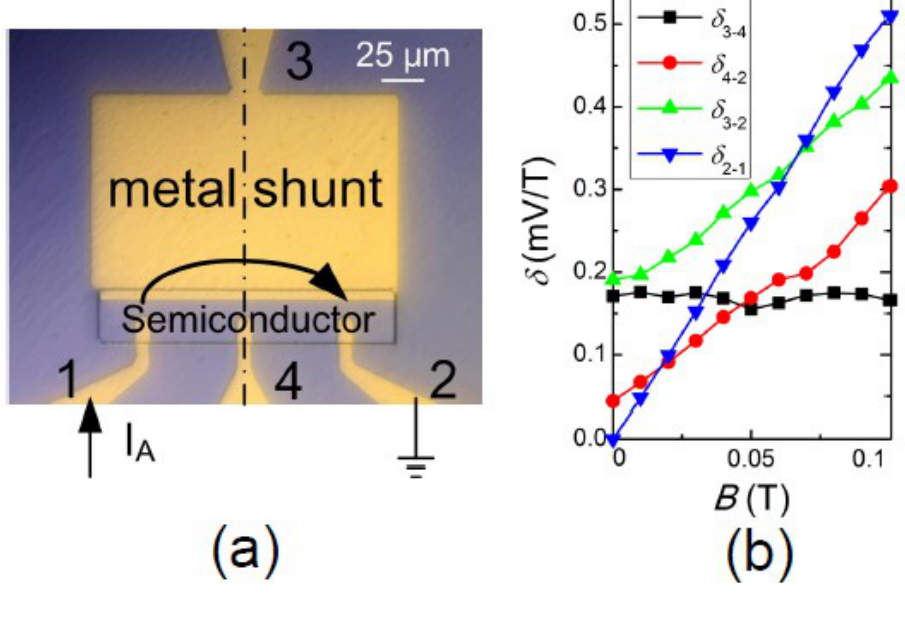
Figure 7. ( a ) Optical micrograph of the three-contact Hall enhanced EMR device. The current is injected through the electrodes labeled as 1 and 2, and the arrow shows the direction of current flow. The output signal is measured through electrode 3 and 2; ( b ) Sensitivity versus magnetic field measured between different electrodes using a bias current of 0.1 mA. 3-2 is the 3-contact Hall enhanced signal, 4-2 is the asymmetric EMR signal, 3-4 is the Hall signal, 2-1 is the 2-contact EMR signal. Reprinted with permission from [42]. Copyright 2012 American Institute of